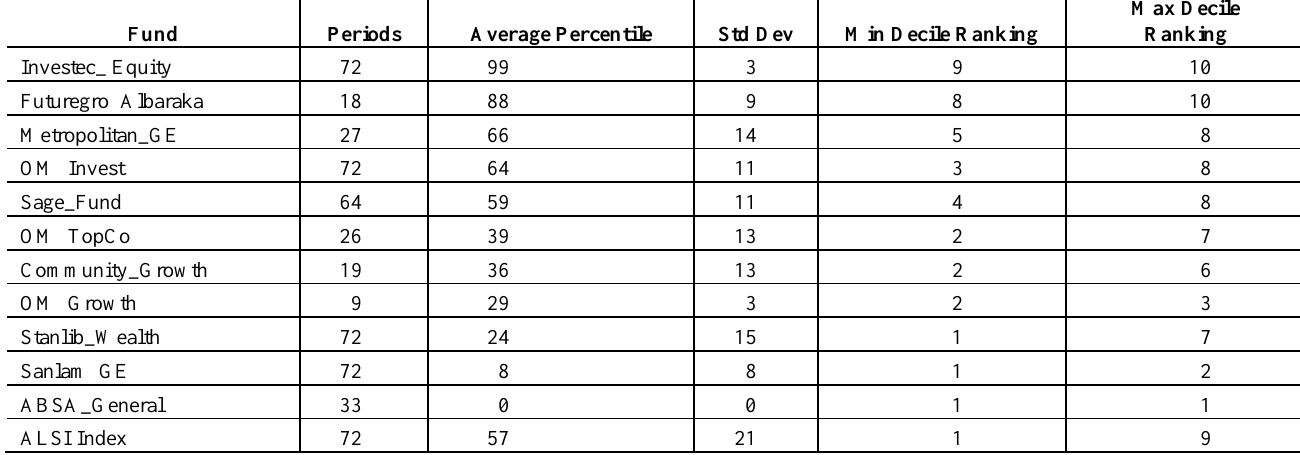
Table 3: Percentile ranking of actively managed funds over rolling 120-month investment periods